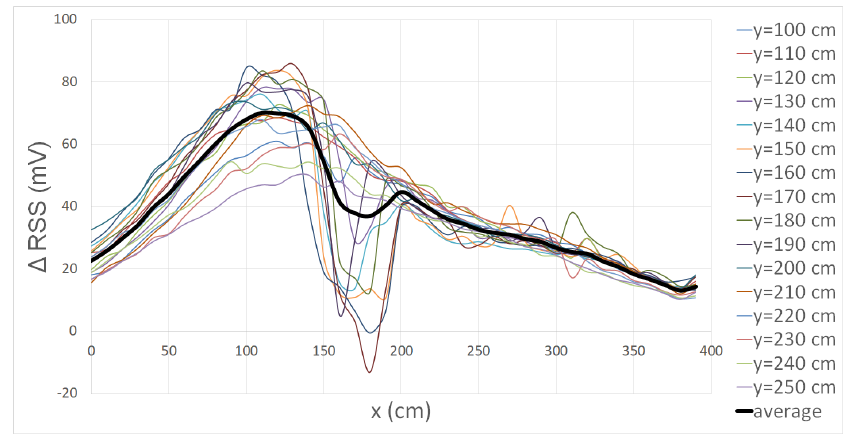
Figure 8. ∆ RSS lapses from Figure 7a. The thick black line represents the average